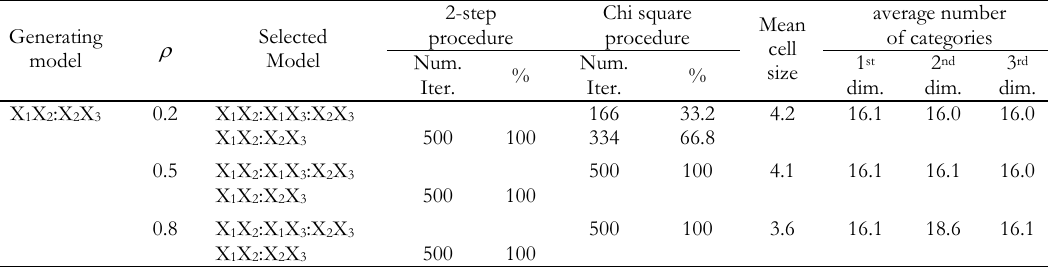
Simulation results. Sample size: 17000